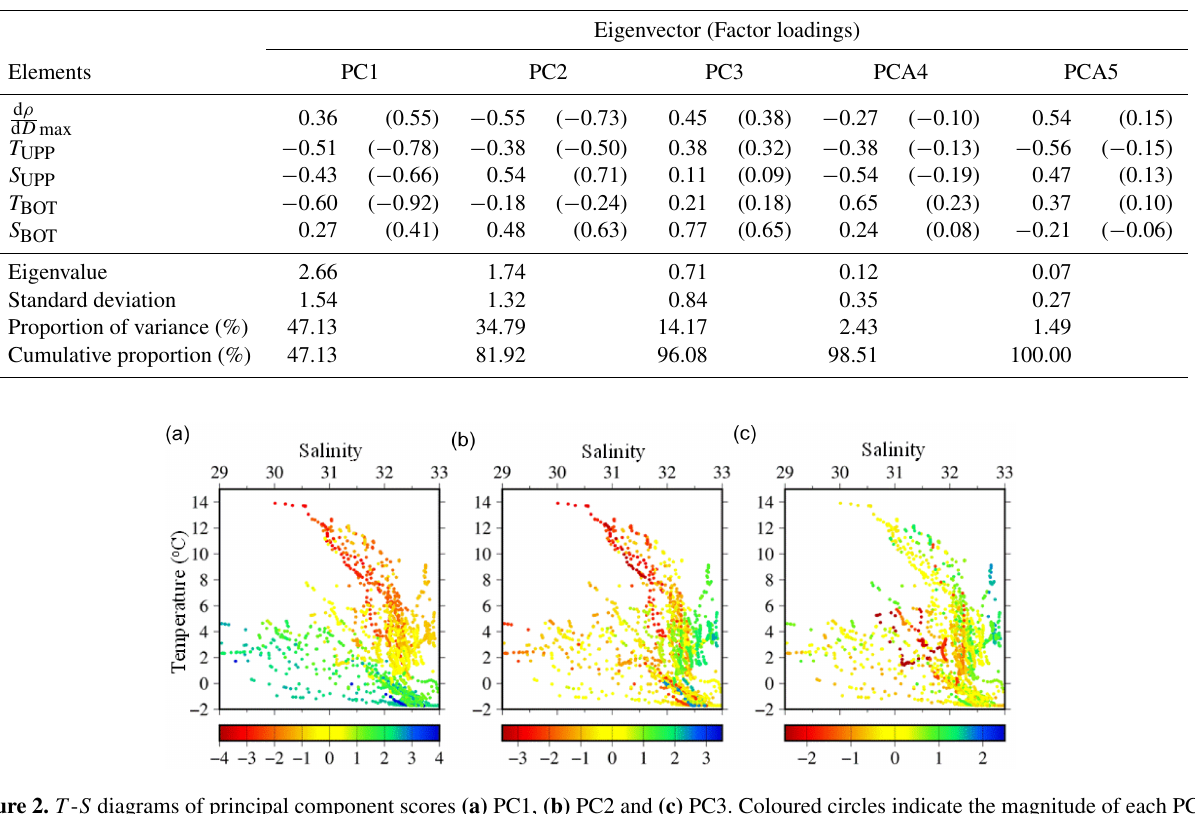
Table 4. Eigenvalue and factor loadings of principle component analysis. The variances and eigenvalue of each principal component (PC) are also given. Descriptions of elements are same as Table 3 (See Table 3).